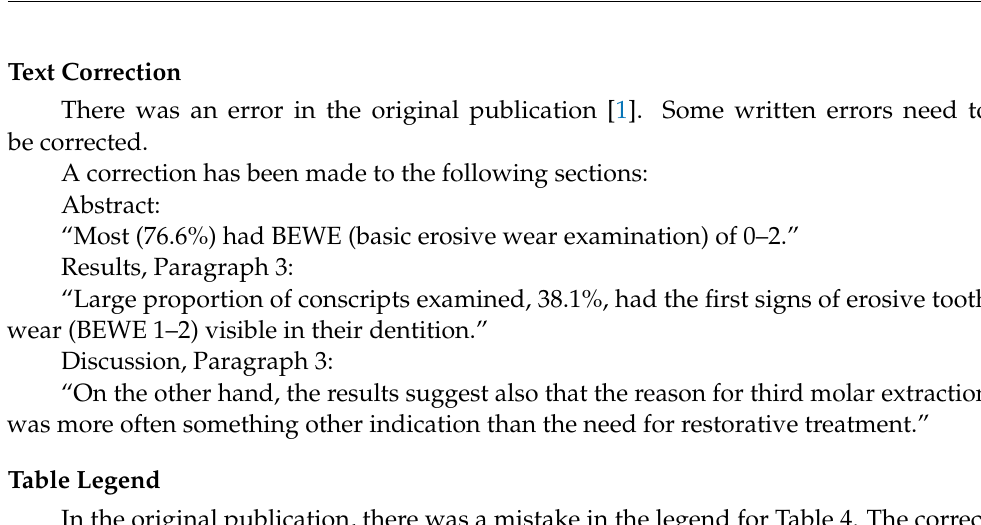
Table 4. Distribution of BEWE score